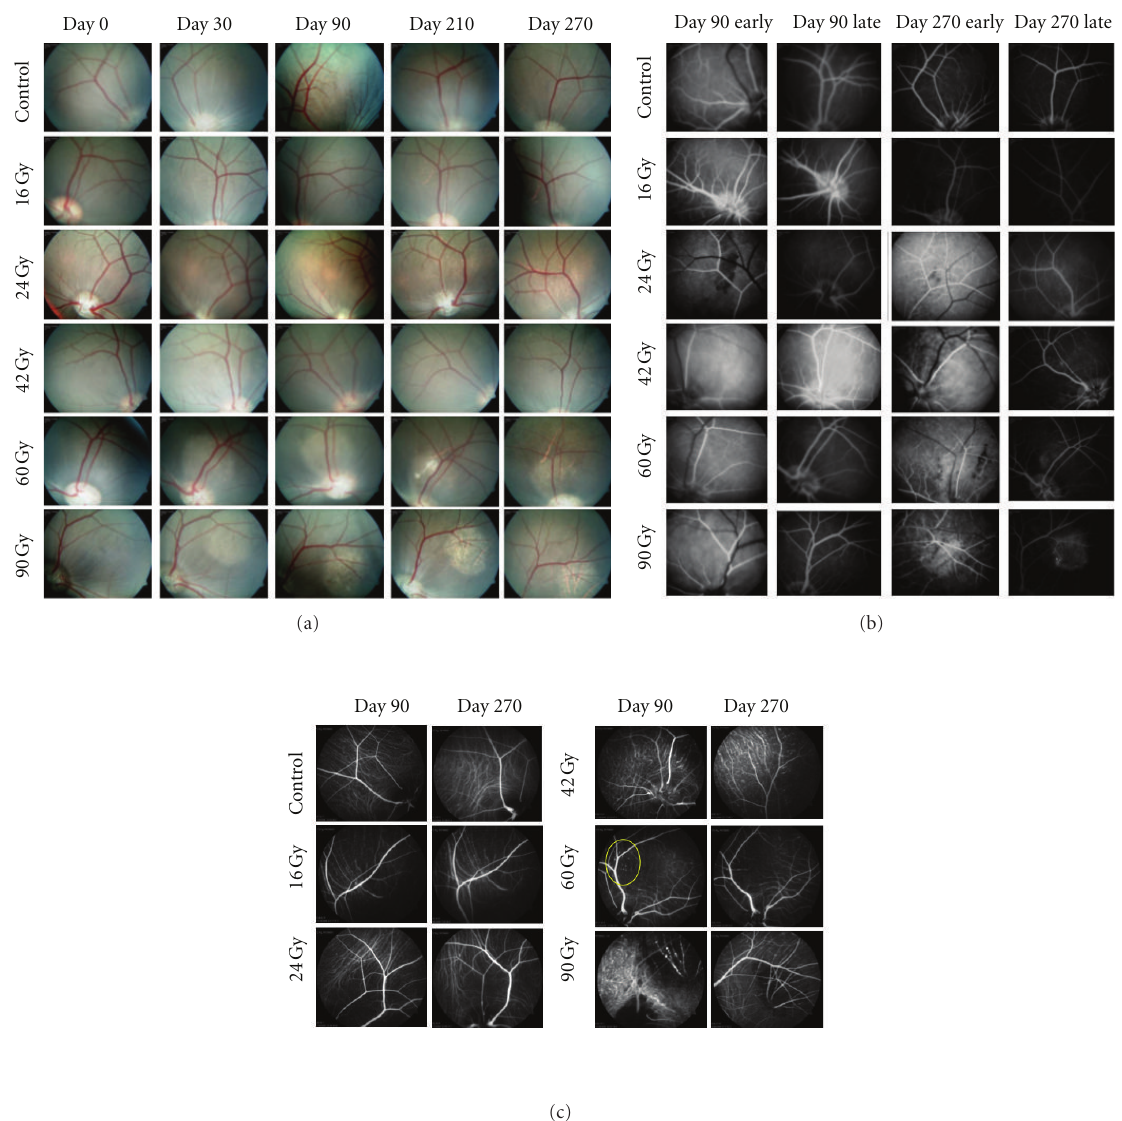
Figure 3: (a) Montage images of fundus photographs showing dose-dependent changes over the time course of the study. In the doses above 24 Gy, cotton wool spots, dot hemorrhage, and eventual atrophy were seen with depigmentation. (b) Montage images of fluorescein angiograms showing dose-dependent changes over the time course of the study. In the doses above 24 Gy, there was early retinal capillary changes with eventual pruning of vessels and late staining consistent with damage to the retinal pigment epithelium and retina vasculature. (c) ICG images demonstrating choroidal capillary obliteration at the 60Gy and 90Gy